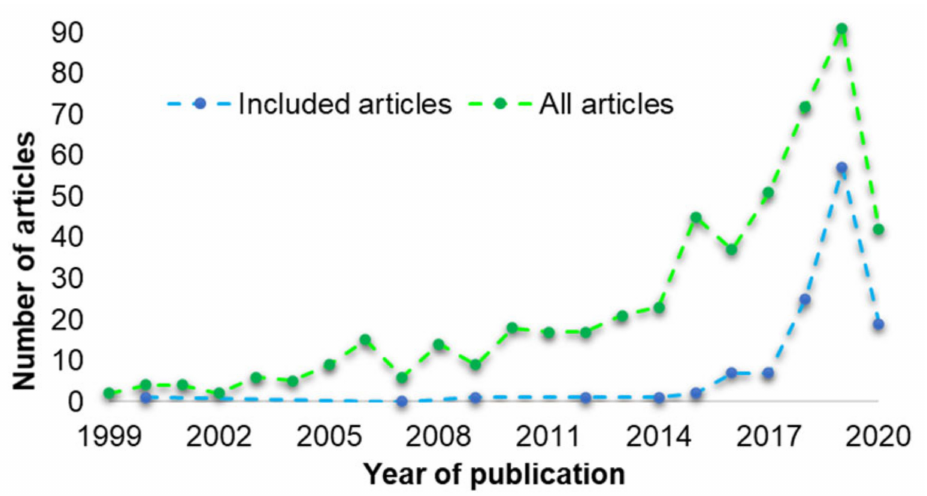
Figure 3. The number of 3D printed oral solid formulations published between 1999 and 2020 (green) and the number of articles included in the systematic review over the same period (blue).